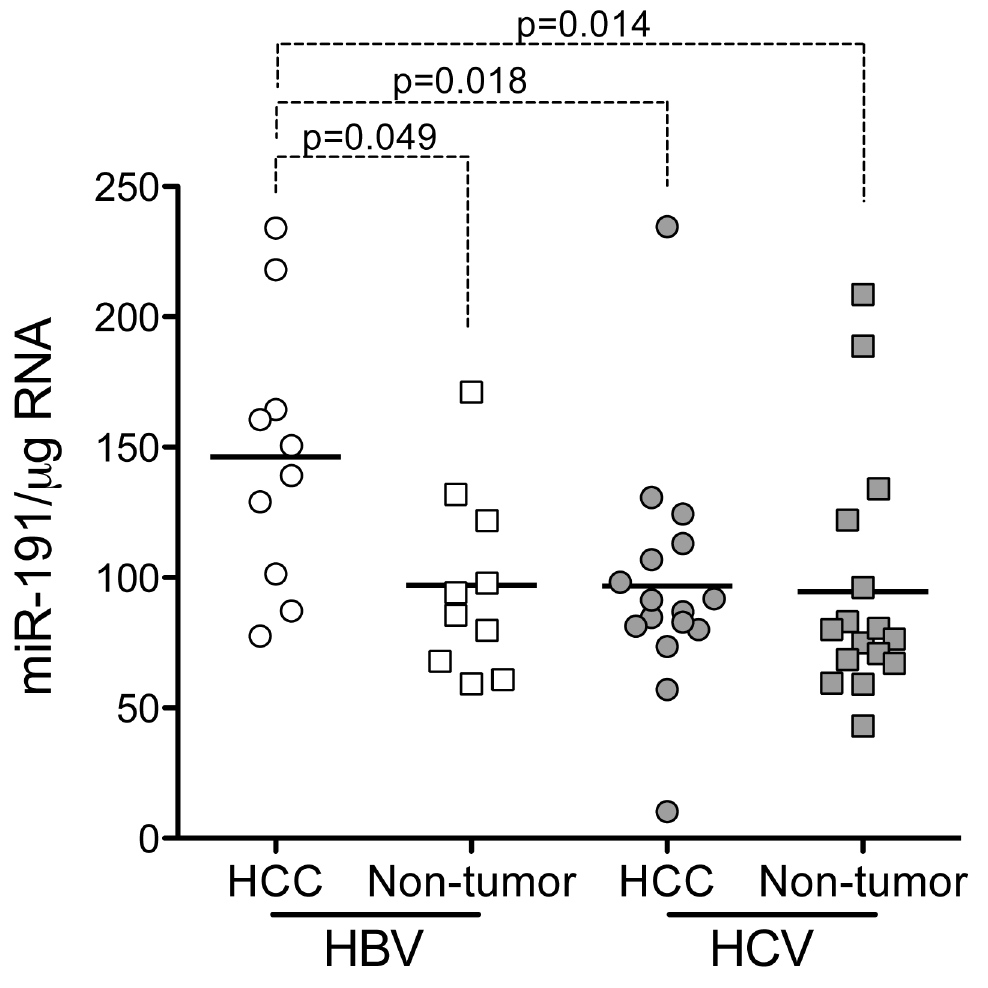
Figure 6. Relative abundance of miR-191 in paired HCC and non-tumor tissue from subjects with HBV or HCV infection. Relative miR-191 abundance in paired tumor and non-tumor samples from HBV- and HCV-infected subjects normalized to total RNA. Statistical significance was assessed in two-sided paired t tests for comparisons between tumor and non-tumor tissue, or two-sided unpaired t test for comparison between infection